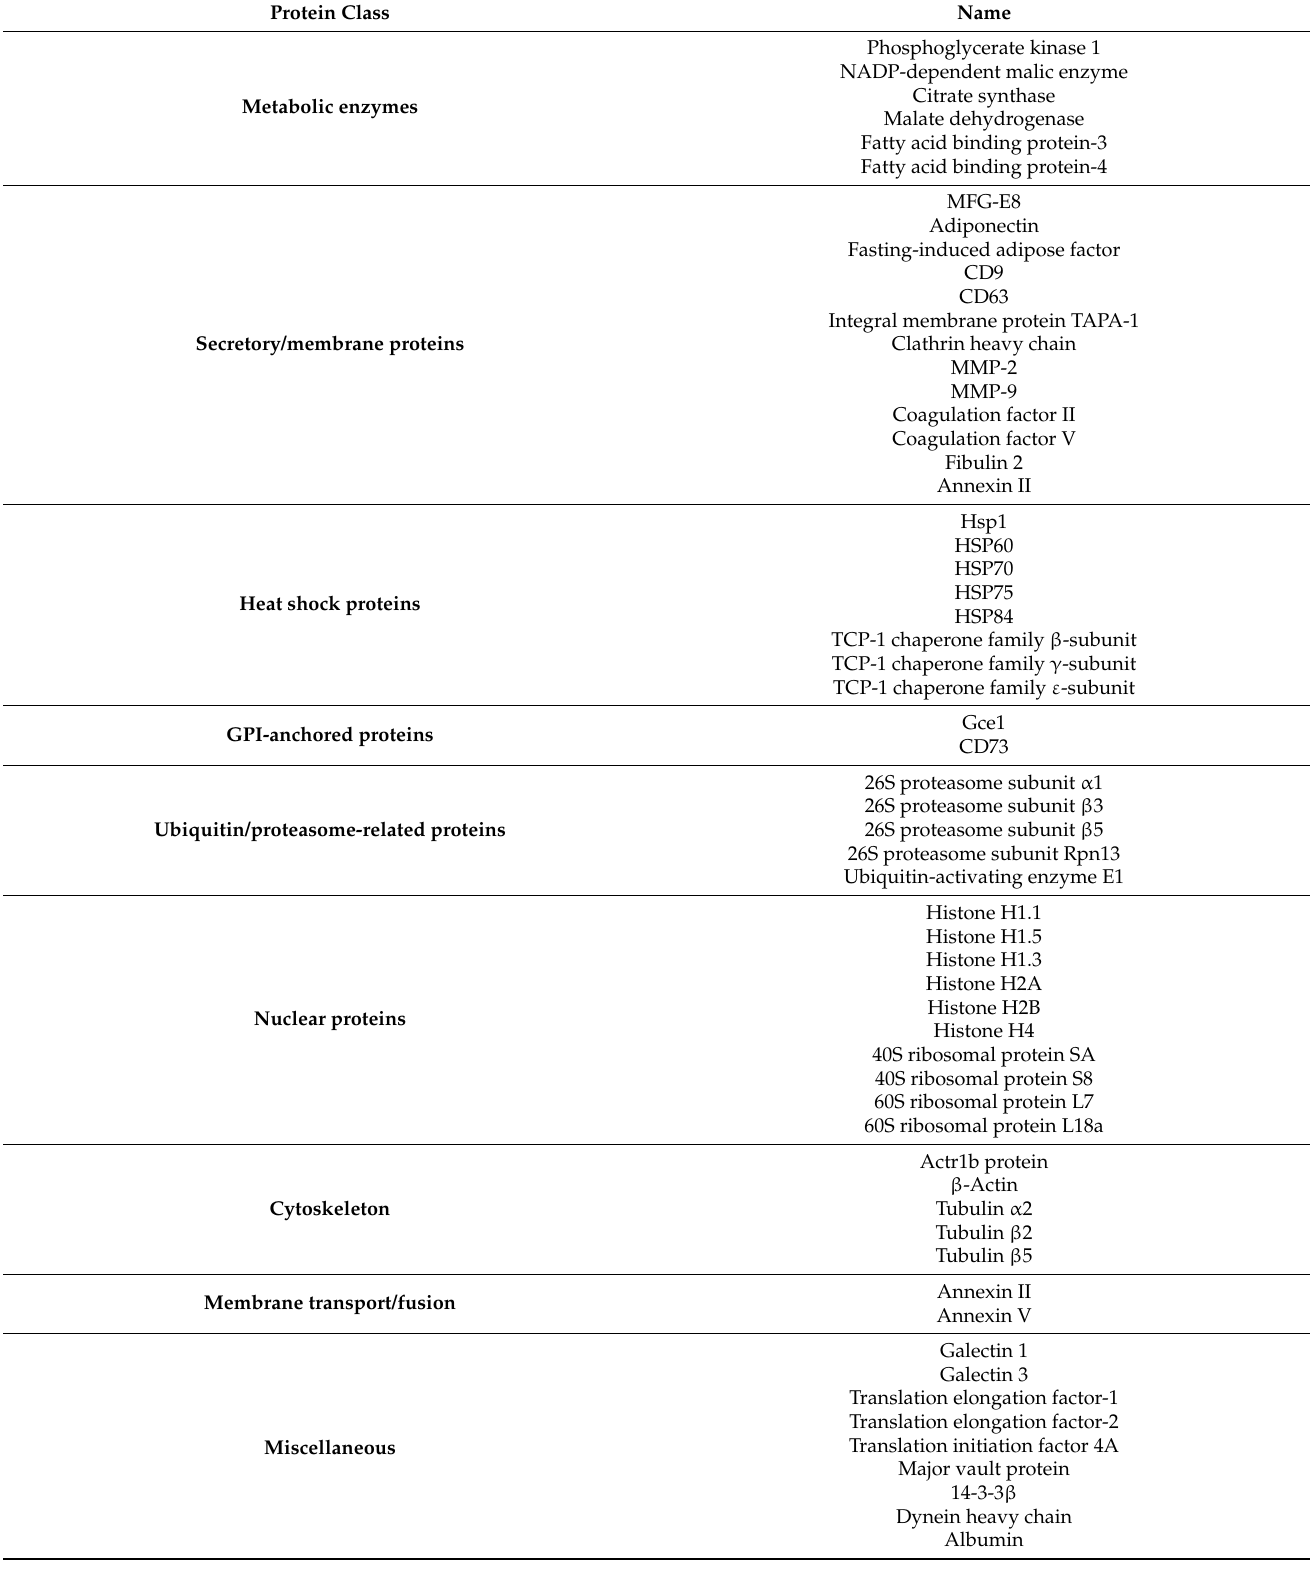
Table 3. Important protein families identified within or externally located on exosomes